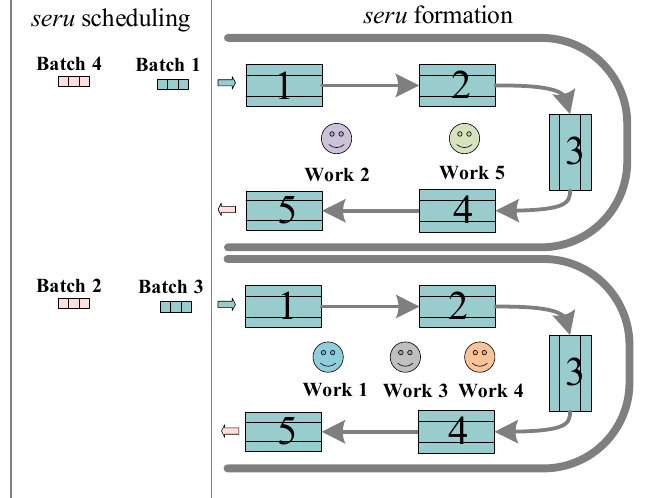
Fig. 1. Example of seru production system with 5 workers and 4 batches